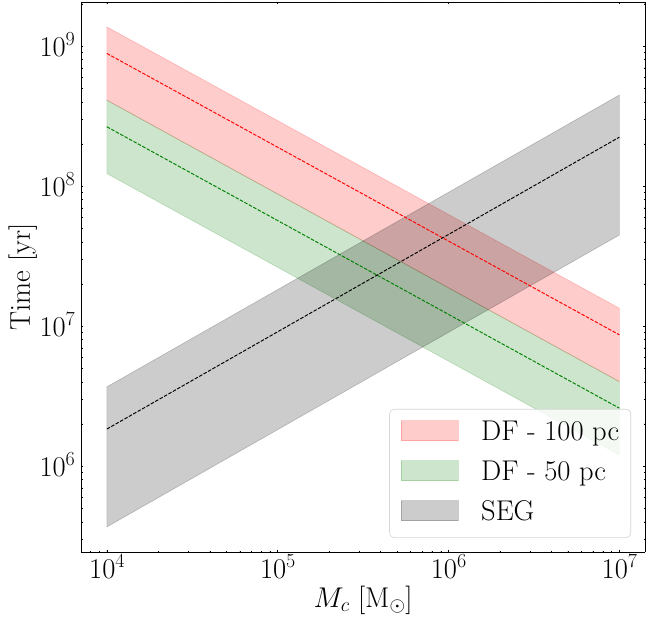
, scale radius (cid:12)